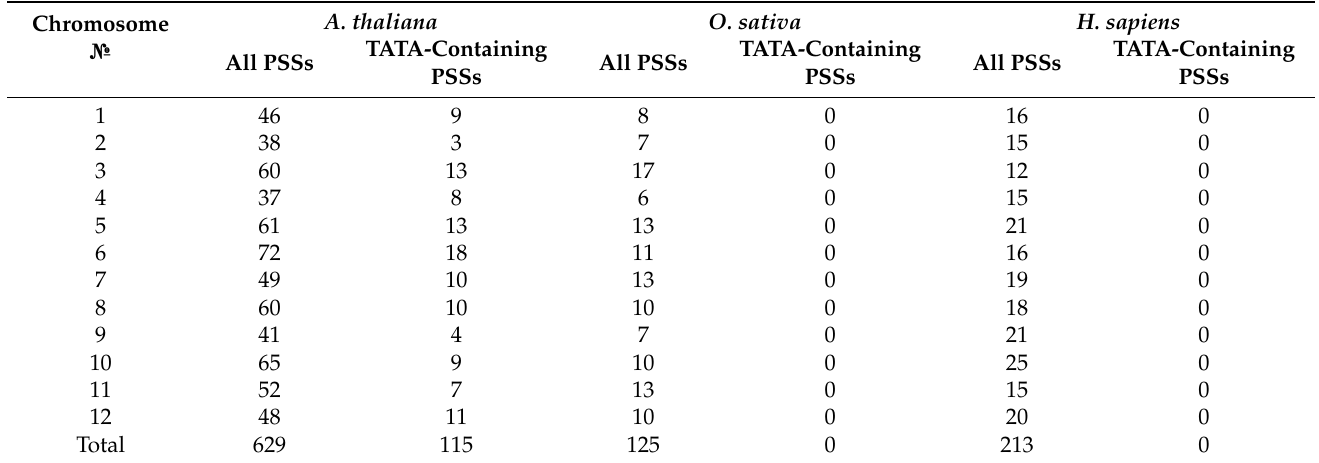
Table 4. Numbers of TSSs identified in the PPSs of the C. annuum genome using TSSFinder with different training